Question: What kind of plot is shown here?
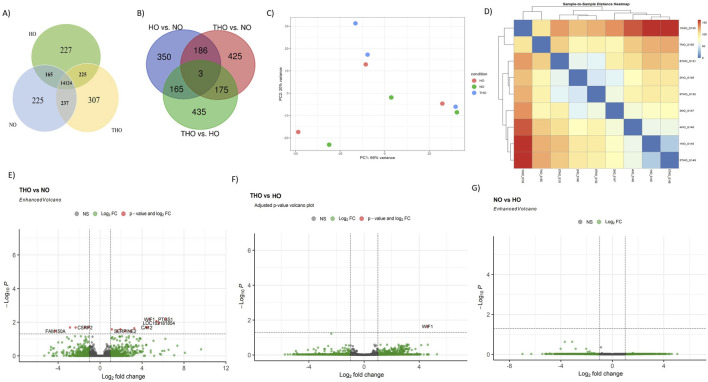
Answer: heatmap